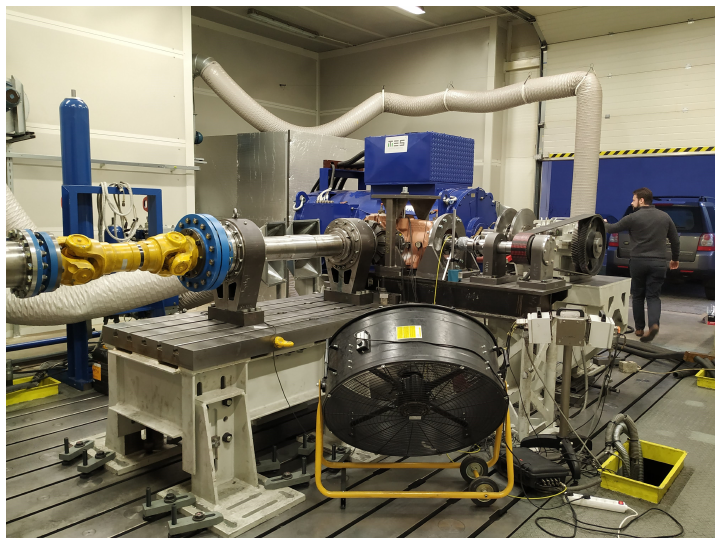
Figure 8. Example of typical arrangement of the test rig with open power flow—WIKOV MGI